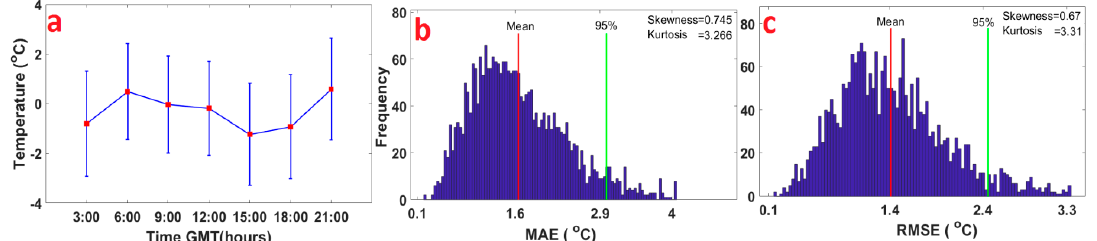
Figure 8. Statistics for differences between modeled and observation air temperatures for all stations.